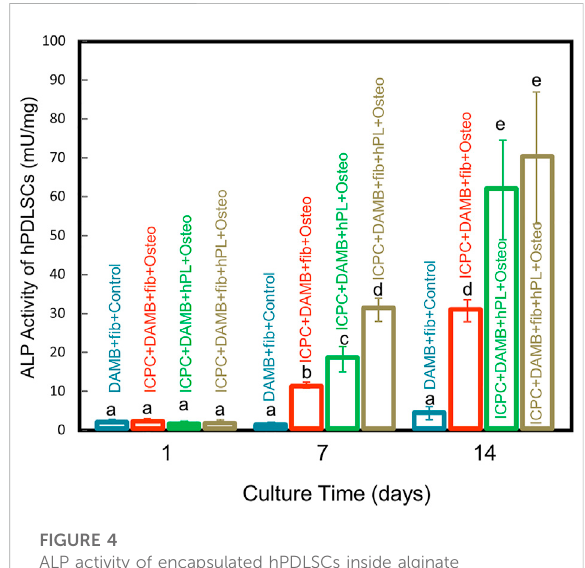
FIGURE 4 ALP activity of encapsulated hPDLSCs inside alginate hydrogel microbeads in the DAMB + fi brin + FBS + control group, ICPC + DAMB + fi brin + FBS+ osteo group, ICPC + DAMB + hPL + osteo group, and ICPC + DAMB + fi brin + hPL + osteo group at 1, 7 and 14 days (mean ± sd, n = 4). Dissimilar letters indicate values that are signi fi cantly different from each other ( p <